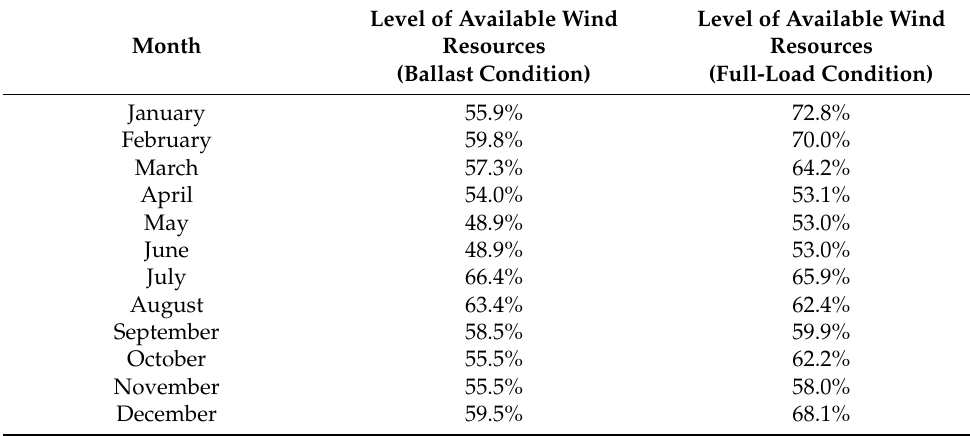
Table 6. Monthly levels of available wind resources on target route in